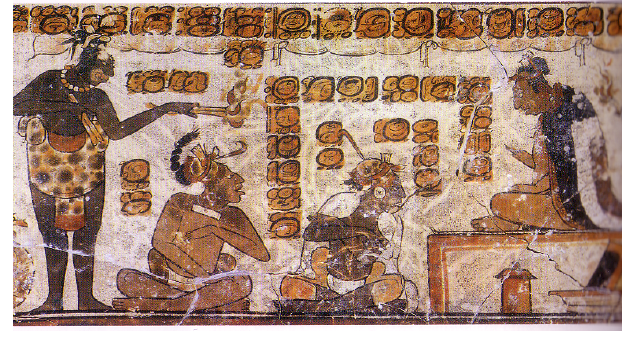
Fig. 2 . Painting from a vessel showing a king (seated on platform) in conversation with two of his lords who are delivering tribute. The symbols along the top and between the figures are written descriptions of the proceedings (reproduced with permission from Reents-Budet 1994:174).